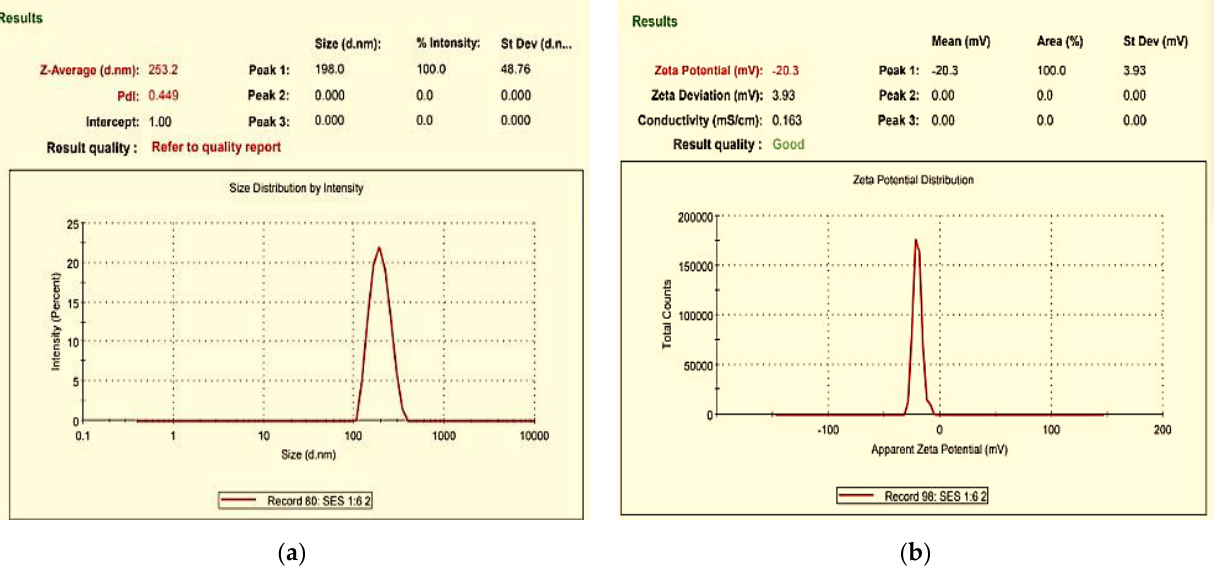
Figure 3. Representative images of ( a ) particle size and ( b ) zeta potential measurement of